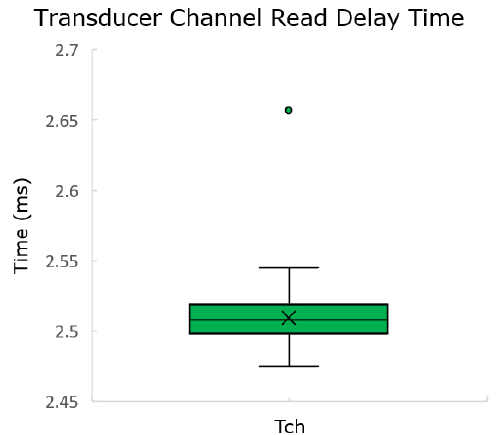
Figure 13. Transducer Channel read delay time measurement.